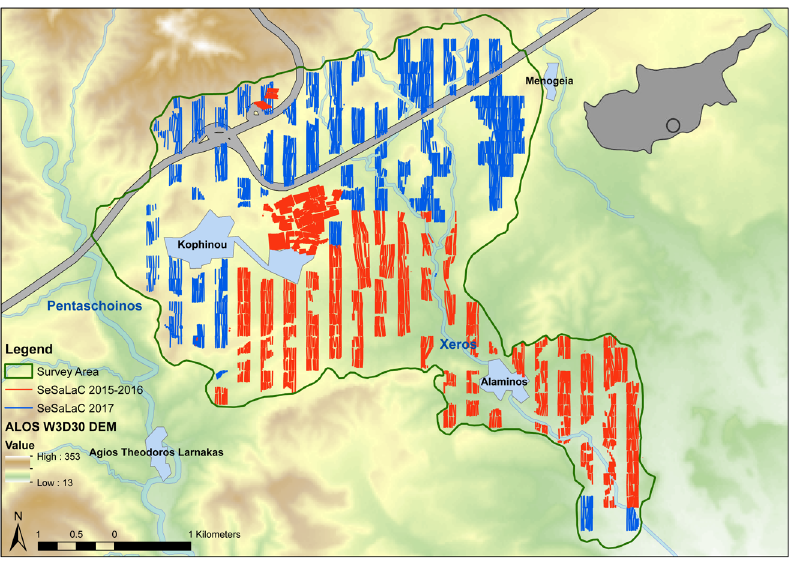
Figure 13: The SeSaLaC survey area with transects (zones of squares: 150x150m) investigated in 2015–2016 and 2017 (map drafted by Charalambos Paraskeva).